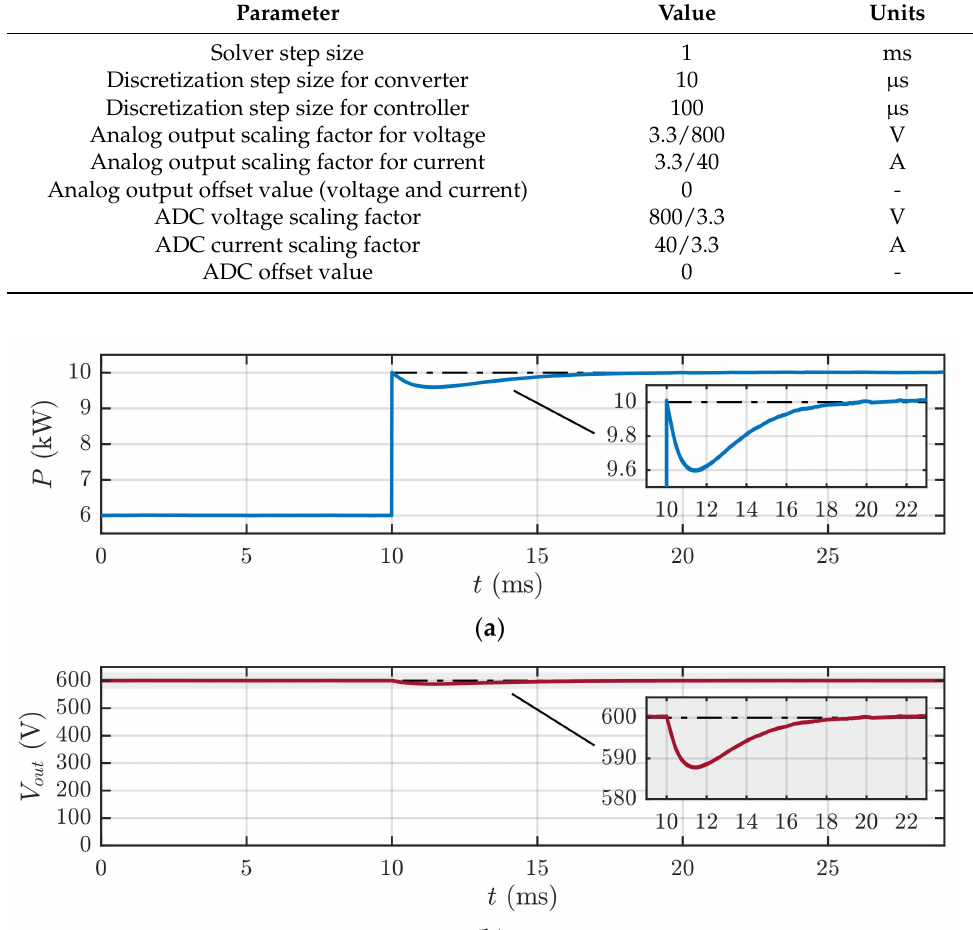
Figure 17. Hardware-in-the-loop testing setup. Table 3. PLECS hardware-in-the-loop parameters.